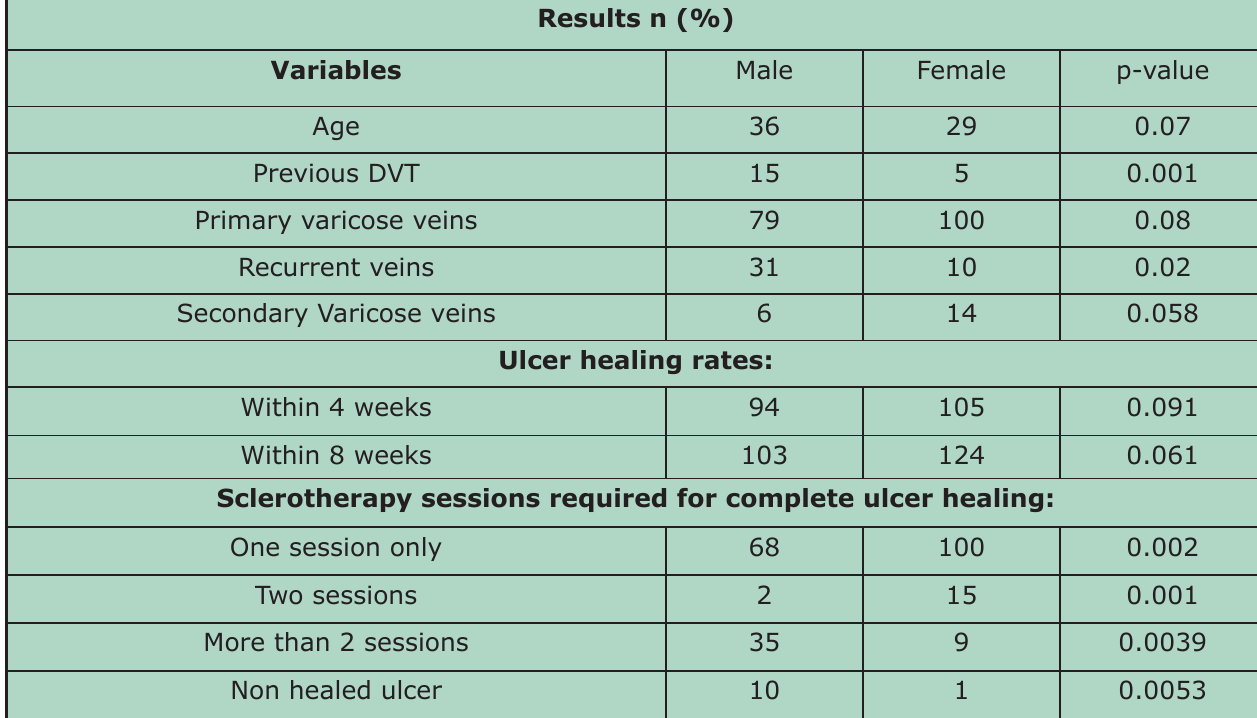
Table-IV: Comparison between Male and female groups in terms of risk factors, ulcer healing, and sclerotherapy